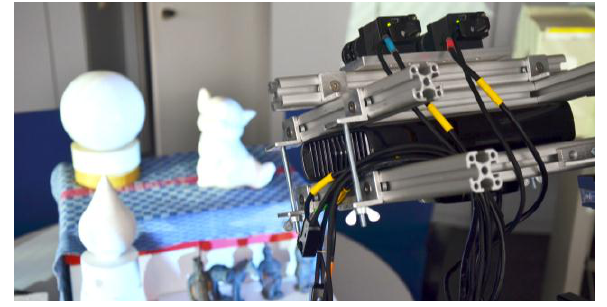
Figure 4: Evaluation setup with two industrial cameras (IDS 2280, 5Mp) at 7.5cm baseline and additional texture projection. The relative orientation for the camera rig was determined using the software Australis in combination with a calibration pattern. The measurement of corresponding points was performed using an ellipsoid fitting for the targets with a precision better than 0.1 pixel. For each stereo pair, one 3D point cloud was computed using the dense image matching solution SURE (figure 5).